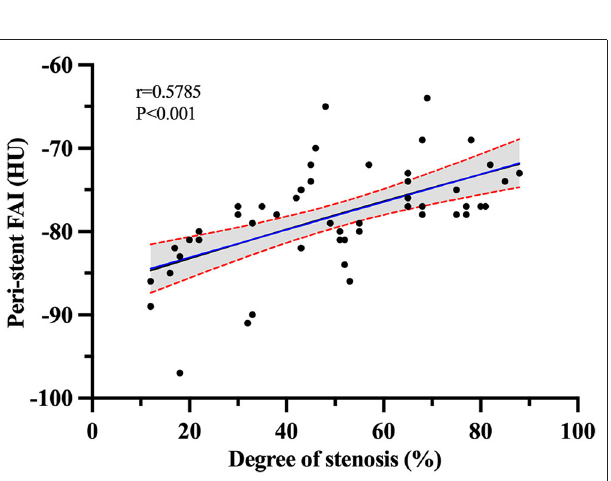
FIGURE 7 | Pearson r correlation analysis between ISR severity and peri-stent FAI values in the ISR